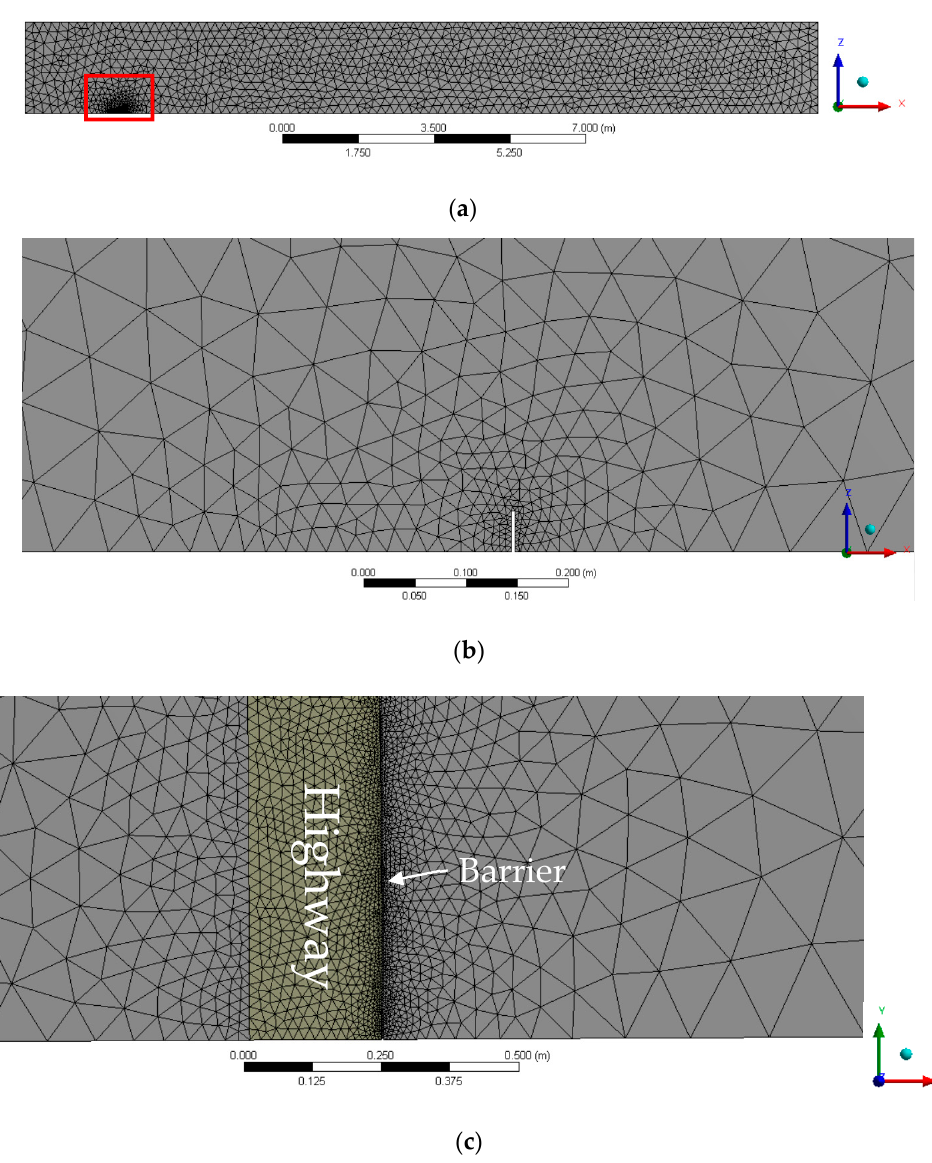
Figure 6. Computational Mesh 2. ( a ) Front view; ( b ) close-up front view; ( c ) close-up bottom view.